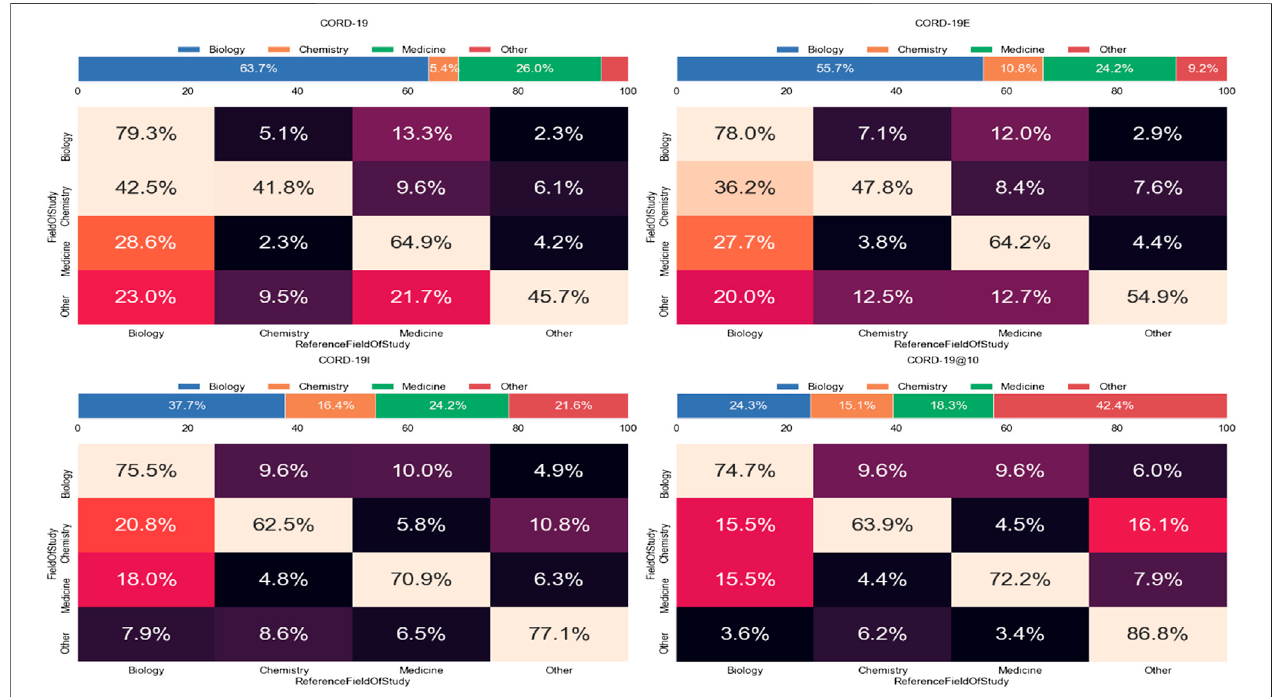
FIGURE12| Topicdistributionandinterdisciplinarycitationdistributionforthetopthreehigh-leveltopicsinclosuregraphexpansions,COVID-19ResearchDataset (CORD-19),CORD-19E,CORD-19I,andCORD-19C.Thevalueineachcellisthepercentageofcitationsgoingfromthe fi eldofstudyontheleft(row)tothe fi eldofstudy on the bottom (column). The bar over each matrix shows the percentage of citations coming from each fi eld.